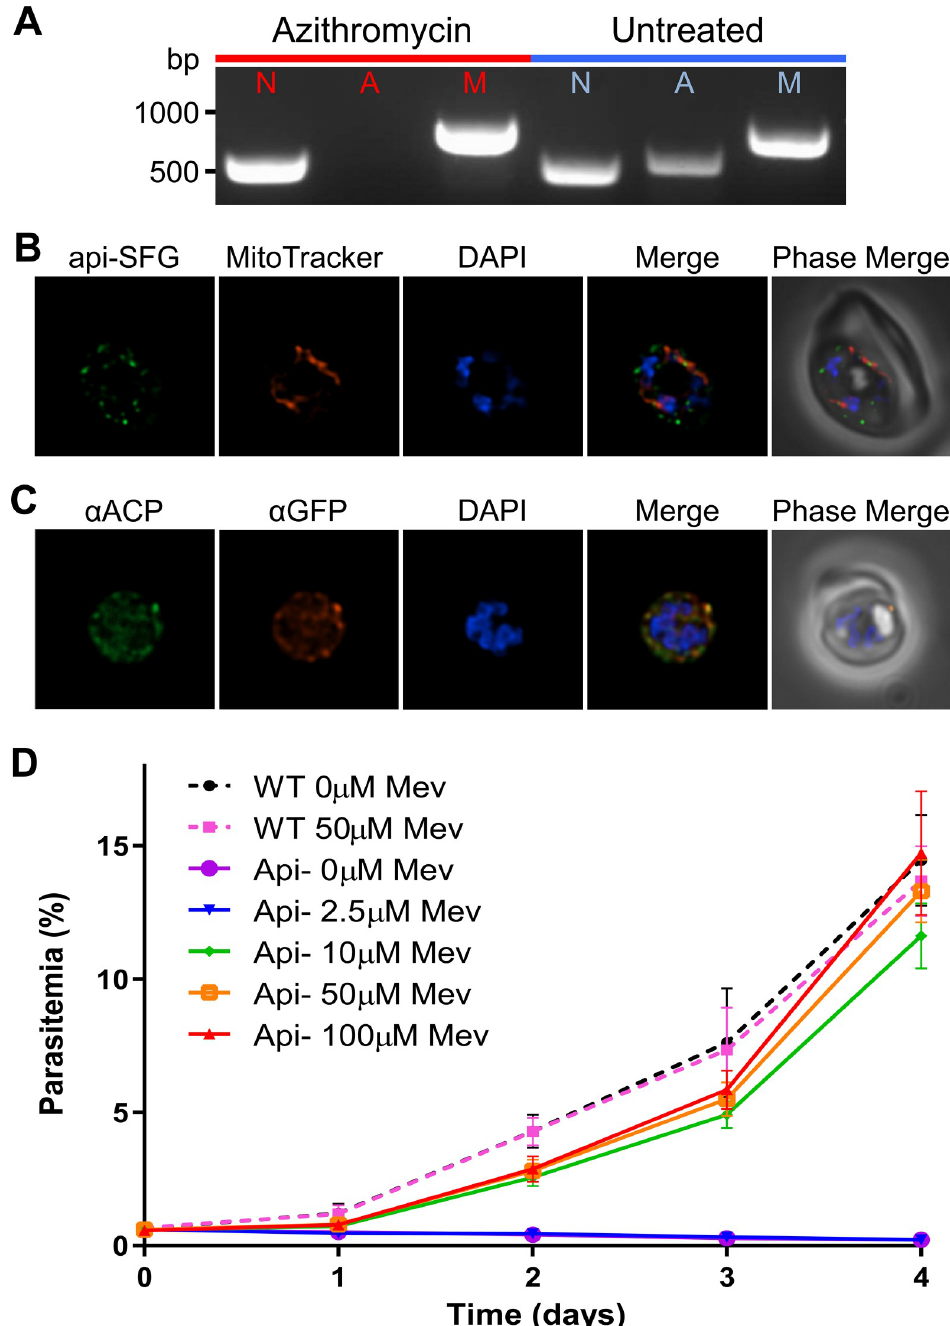
Fig 4. Generation and characterization of an apicoplast-disrupted PfMev parasite line. A) Attempted detection of nuclear, mitochondrial, and apicoplast genomes by PCR amplification of the genes ldh (nuclear, N), sufB (apicoplast, A), and cox1 (mitochondrial, M) from PfMev parasites treated with 100nM azithromycin and 50 μ M mevalonate for one week (red), in addition to an untreated control (blue). Failure to amplify sufB in PfMev parasites treated with azithromycin/mevalonate indicates loss of the apicoplast organelle. B) Live fluorescence microscopy of PfMev parasites after treatment with 100nM azithromycin and 50 μ M mevalonate for one week, showing a disrupted organelle phenotype, with multiple discrete vesicles instead of a single intact organelle. The apicoplast is labeled with the api-SFG protein (green), the mitochondrion is stained with MitoTracker (red), and nuclear DNA is stained with DAPI (blue). C) Immunofluorescence co-localization of api-SFG with the apicoplast marker ACP, with α GFP (red), α ACP (green), with nuclear DNA stained with DAPI (blue) in fixed apicoplast disrupted PfMev parasites. D) Growth curve of